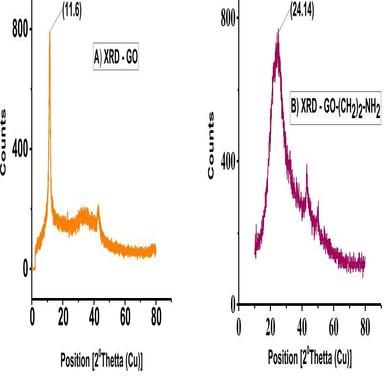
The XRD pattern for A) pure graphene oxide, B) GO-imi- (CH2)4-NH2.